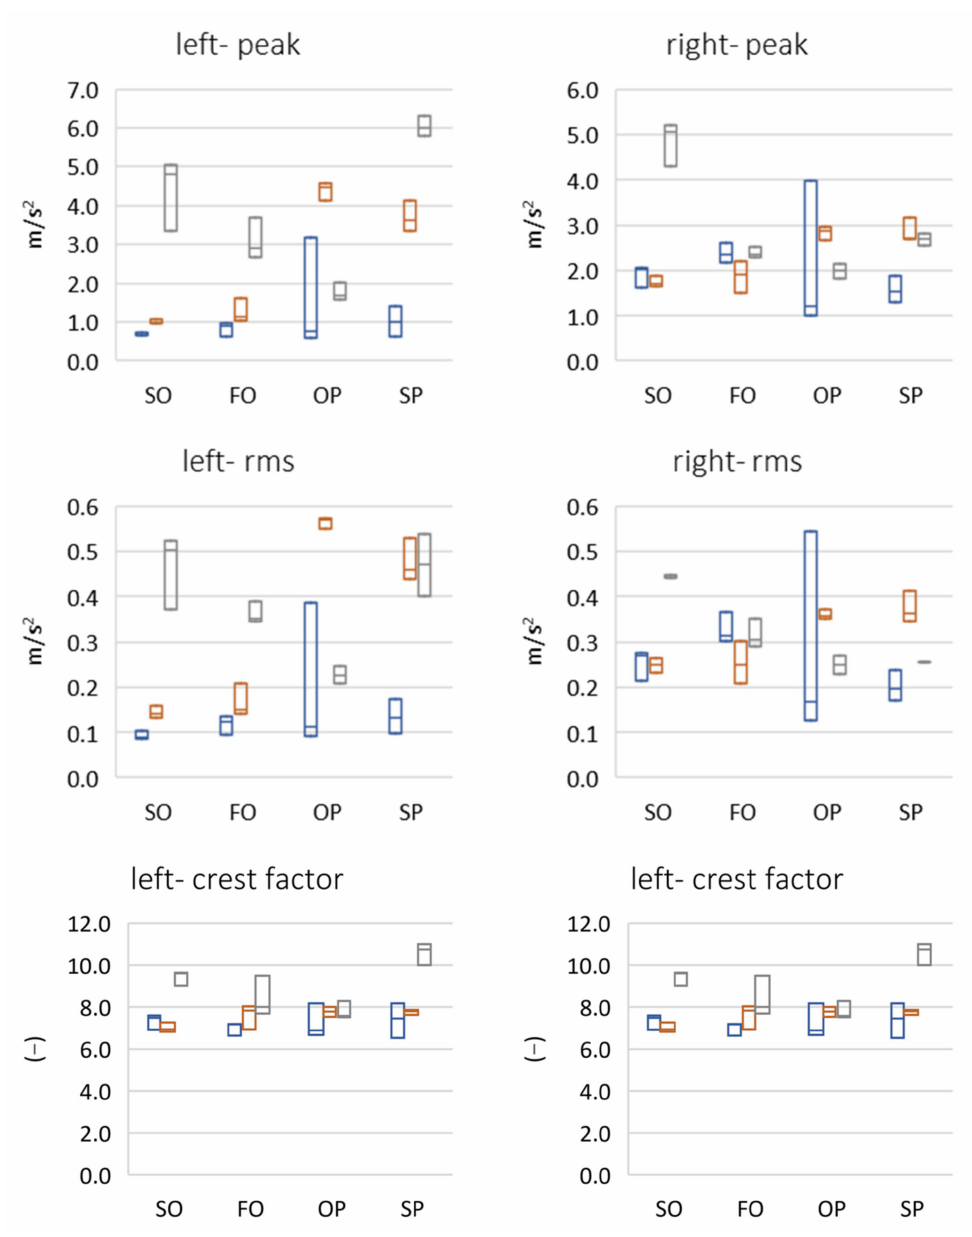
Figure 6. Time domain results of vibration signals ( left and right side)—energy parameters